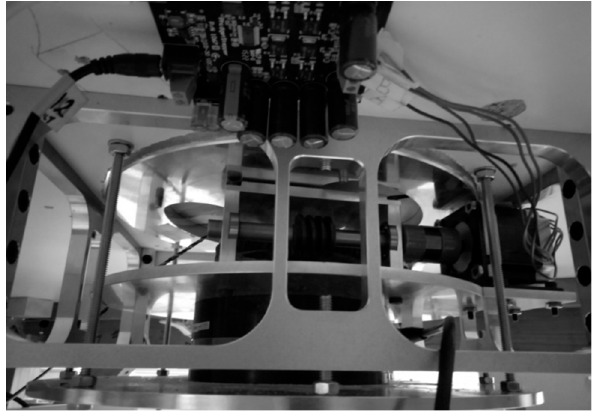
Figure 15. Aerodynamic loading scales.